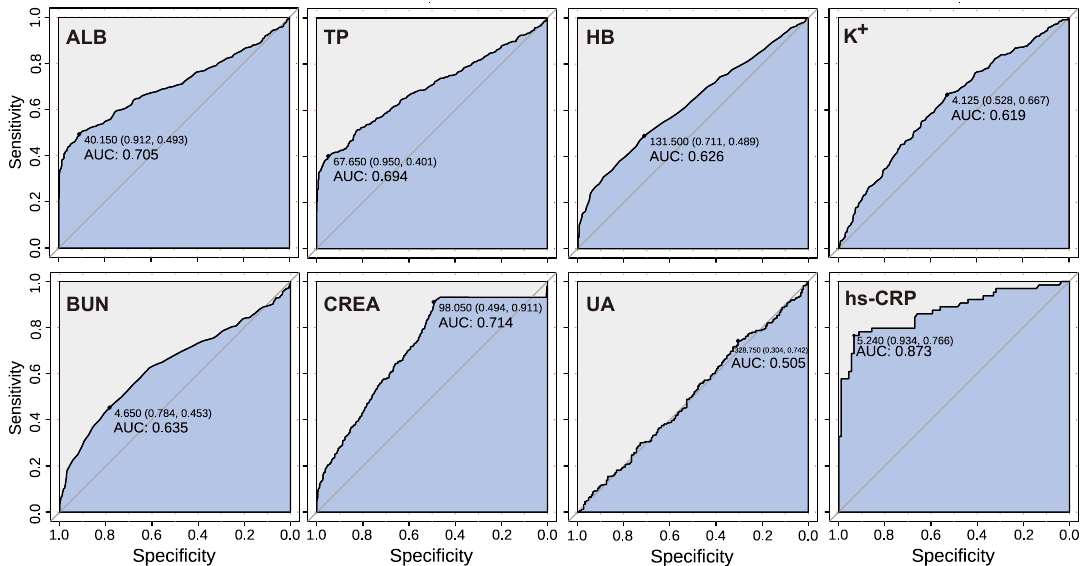
Figure 6. The ROC curve of the single indicator prediction model. The predictive effect of eight single indicator prediction models can be quantified by AUC to evaluate the efficiency of the model prediction.